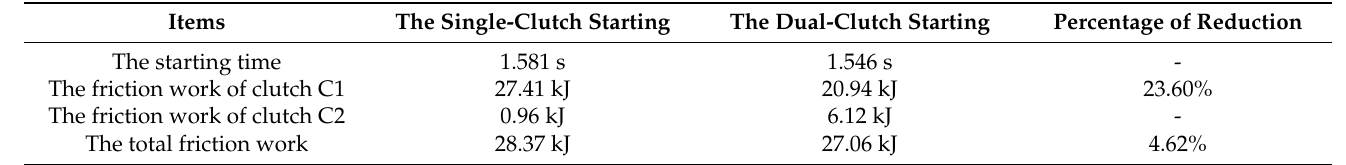
Table 6. The data of the simulation results of quickly starting.